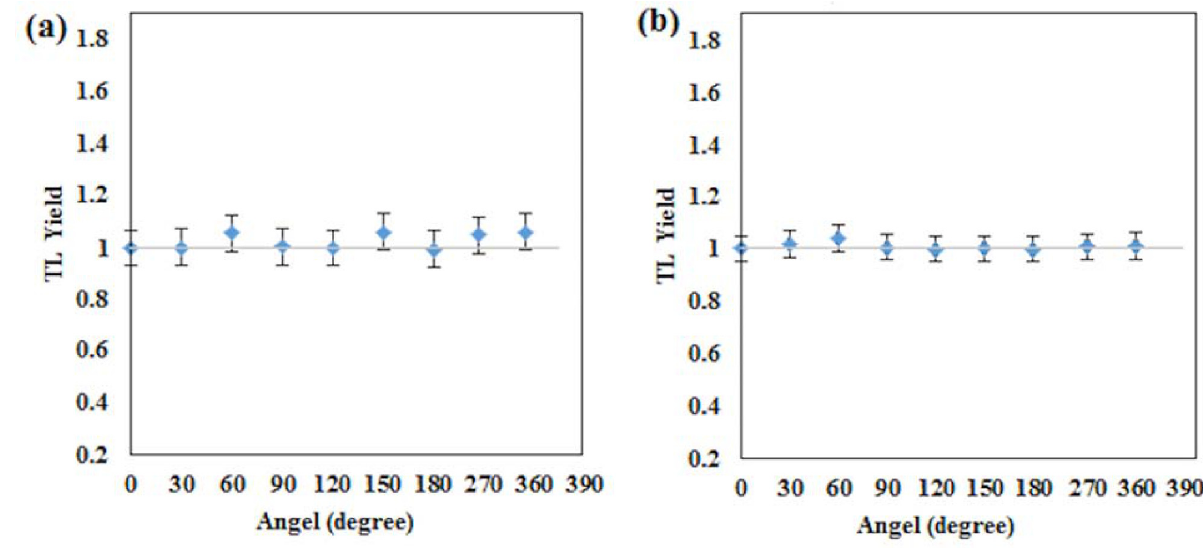
Fig 10. The normalized TL Yield of angular dependency at 0 degree. The fig indicate that the fibre optic detectors have minimal ( < 1%) angular dependency For (a) 42 μ m core sizes, and (b) PCF-collapsed fibres.